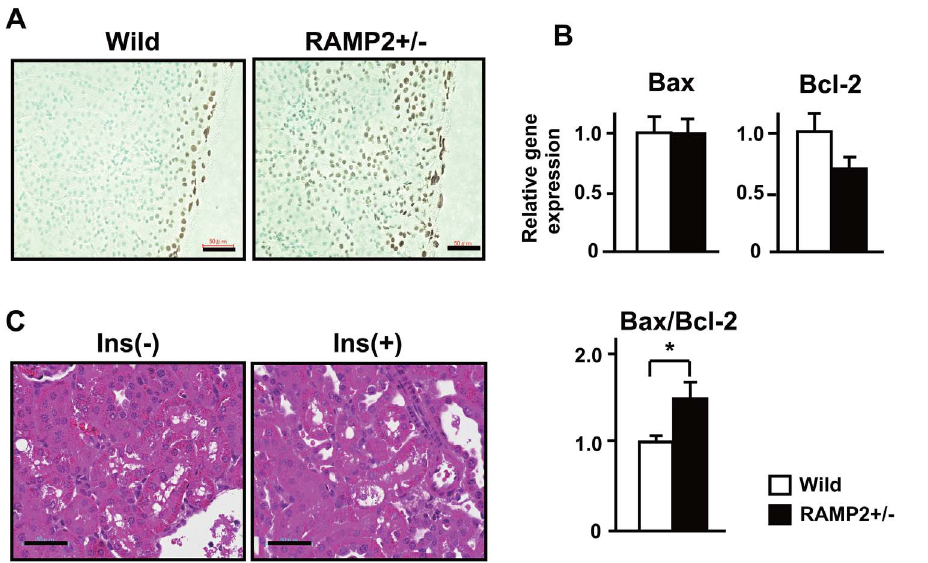
Figure 3. STZ-induced tubule cell death was enhanced in RAMP2 + / 2 kidneys. (A) TUNEL assays of the renal cortex 4 weeks after STZ administration showed tubule cell death to be increased in RAMP2 + / 2 kidneys. (B) Quantitative real-time PCR analysis of samples from the renal cortex. Shown are the relative gene expression levels of Bax and Bcl-2 (upper panels). Data from the wild-type control group were assigned a value of 1. Note the downregulation of Bcl-2 in RAMP2 + / 2 kidneys indicated by the higher Bax/Bcl-2 ratio (lower panel). n=5 in each group. Bars are means 6 SEM. *p , 0.05. (C) H&E staining of the renal cortex from RAMP2 + / 2 kidneys 2 weeks after STZ administration, with or without insulin (Ins) treatment. Although insulin-treated RAMP2 + / 2 mice had normal blood glucose levels, they showed the same level of tubular injury as mice not receiving insulin. Arrows indicate vacuolated proximal tubules. Scale bars=50 m m (A), (C).